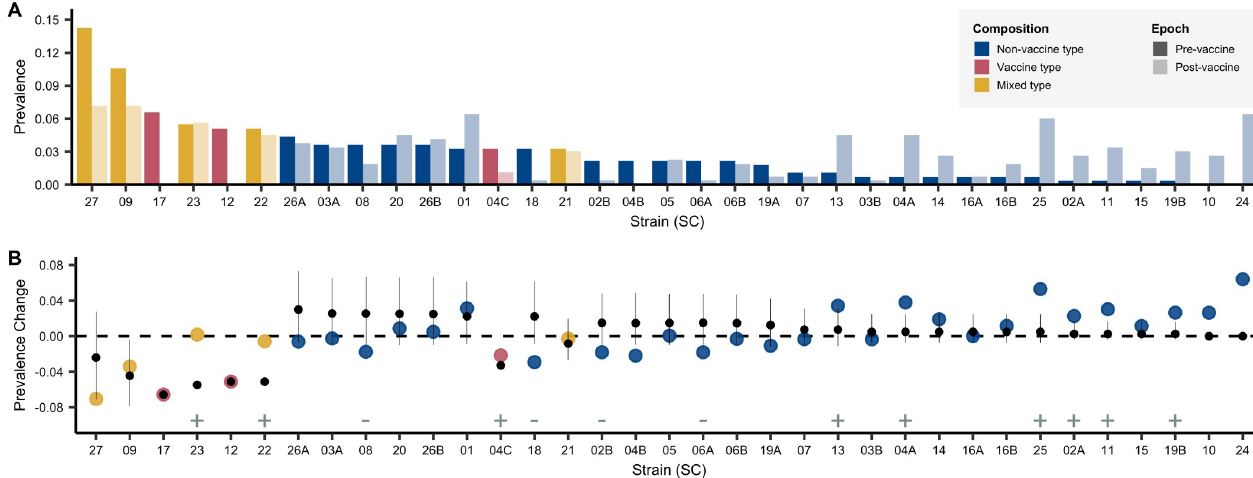
Fig 1. Strain’s prevalence. A. Pre-vaccine to post-vaccine SCs. Strains are ordered from highest to lowest pre-vaccine prevalence. Raw data used in this figure are included in S1 Table. Observed prevalence change calculated as post-vaccine frequencies minus pre-vaccine frequencies. Changes in prevalence are compared with that expected under a pro rata null model (i.e., not using the predictive methods in this paper). Observed changes in prevalence are represented by points colored by the serotype composition of the strain: NVT only, PCV7 VT only, and VT-NVT. The point and whiskers show the prevalence change expected if all VT strains were removed and NVT increased proportional to their pre-vaccine prevalence—i.e., in a null model of pro rata increase in which only the VT strains were removed and all NVT strains increased equally in proportion to their pre-vaccine prevalence. The dot is the median, and the whiskers give the 2.5% and 97.5% quantiles of predicted changes under the null model using 10,000 bootstraps from pre-vaccine samples. Significant differences between the changes in prevalence from the pro rata model and the observed data are denoted with plus and minus signs specifying strains that were significantly more ( n = 9) or less ( n = 4) common, respectively. Among the most successful were strains that contained both VT and NVT isolates (SC-22 and SC-23) whose NVT component included serotypes 6C, 15C, and 35B, as well as SC-24 and SC-25, which were dominated by the NVT serotypes 23A and 15C, respectively. SC-27 is polyphyletic, composed of an aggregate of strains that are at low frequency in the overall population. Compared with strains composed of solely NVT isolates, those with mixed NVT-VT had marginally higher risk differences, indicating greater success than expected under the null model ( β = 0.03, SE = 0.015, F(1,29) = 3.67, p = 0.06). Two strains that emerged during the study period (SC-10 and SC-24) were not included in this analysis as they were not present at the first time point. See S1 Data and S1 Code for details. NVT, nonvaccine serotype; SC, sequence cluster; SE, standard error; VT, vaccine serotype; VT-NVT, mixed VT and